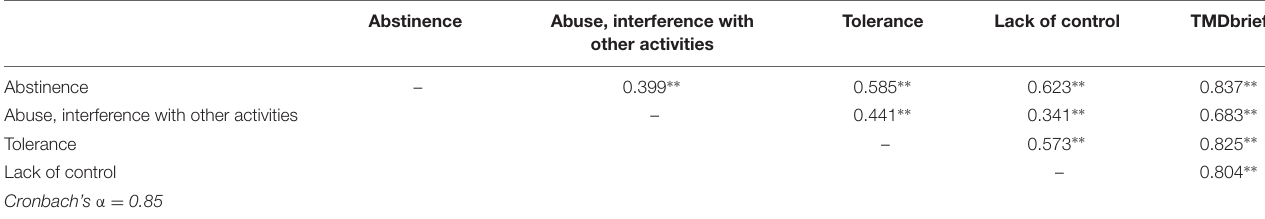
TABLE 7 | Factor correlation matrix